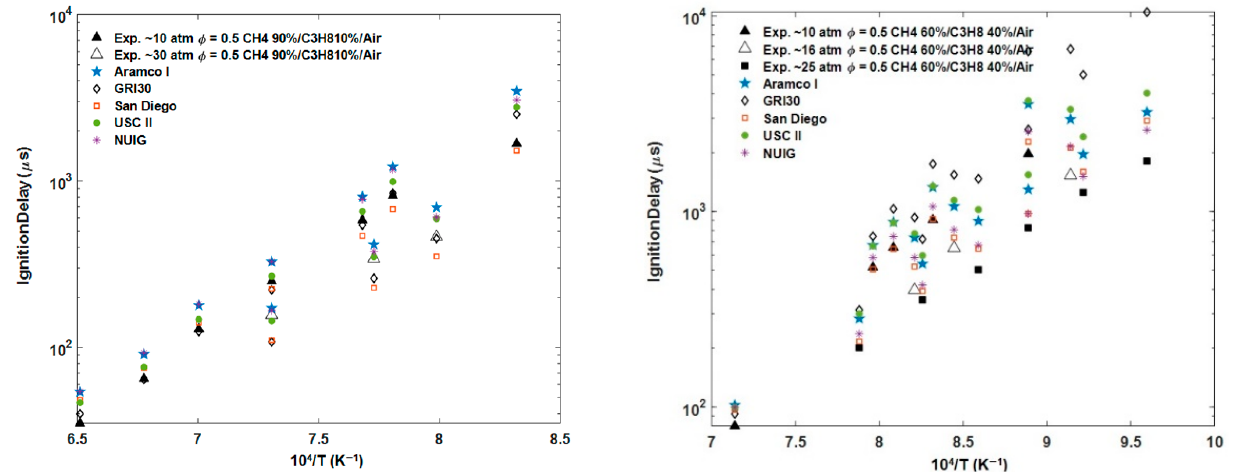
Figure 8. Comparison of ignition delay times of CH 4 /C 3 H 8 mixtures with experimental data at Φ = 0.5 and different pressures: Left : 90%CH 4 /10%C 3 H 8 ; Right : 60%CH 4 /40%C 3 H 8 [41].